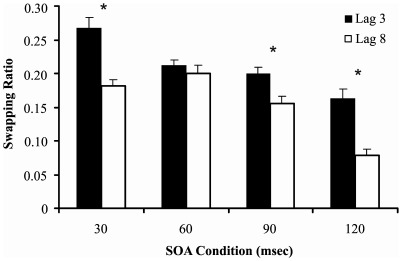
Order-error ratios for lags 3 and 8, across four SOA conditions (30 msec, 60 msec, 90 msec, 120 msec).Asterisks indicate a significant difference between order-errors at lag 3 and lag 8. Error bars represent standard errors of the mean.